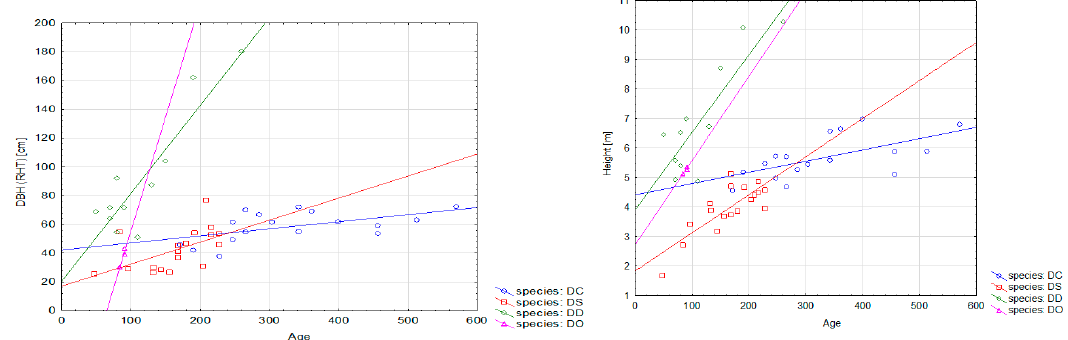
Figure 5. Speed of growth described by DBH and tree height compared to the age of the trees. Key: DC— Dracaena cinnabari ; DS— D. serrulata ; DD— D. draco ; DO— D. ombet.